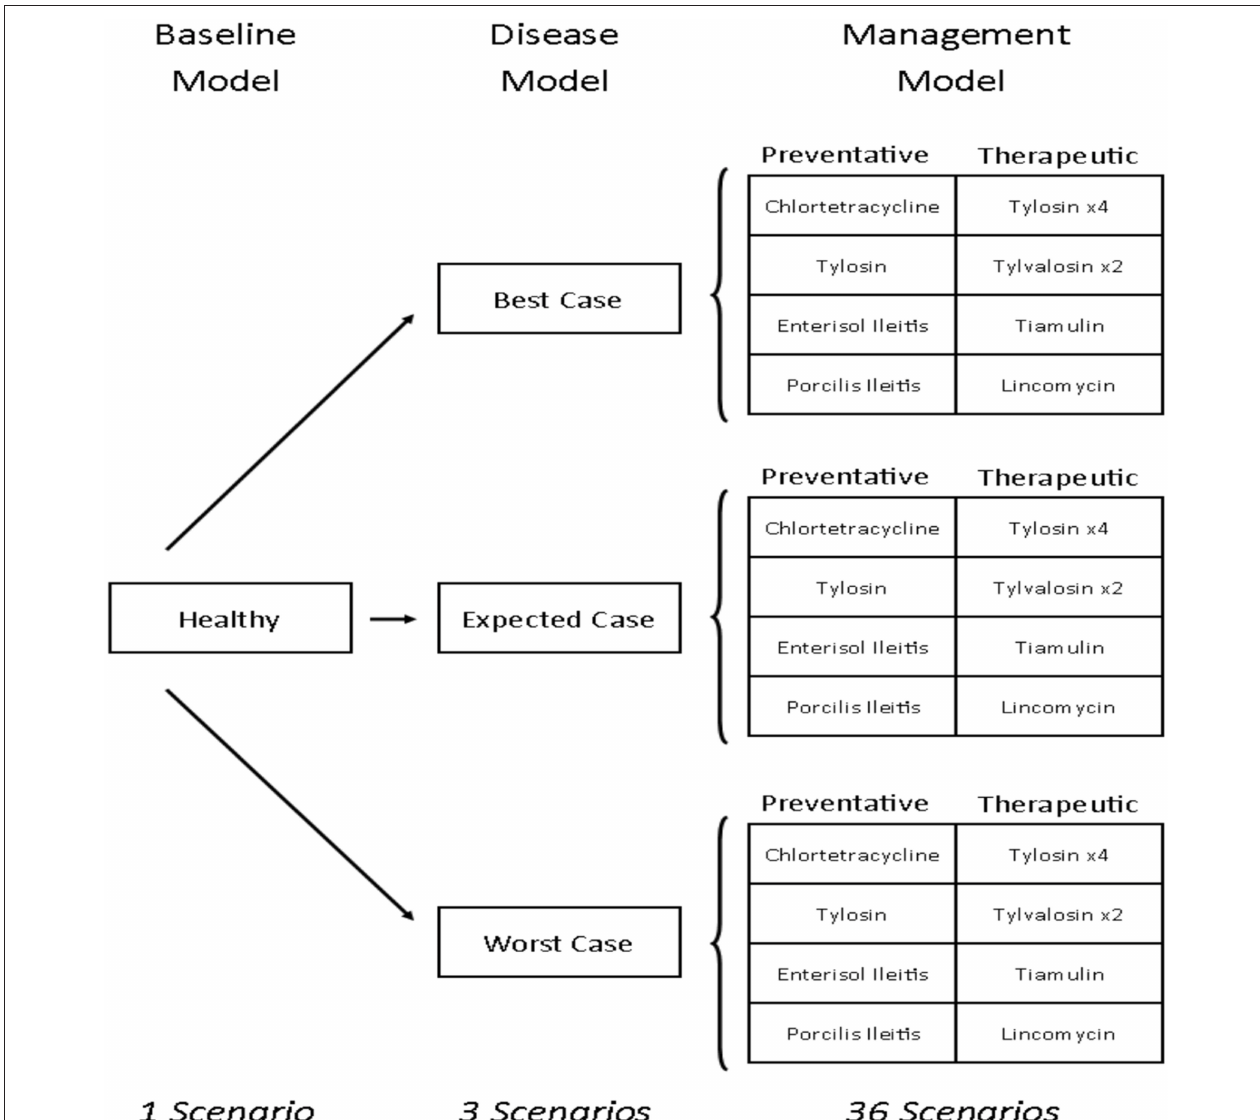
FIGURE 1 | Pig barn scenarios. Tylosin × 4 indicates that there are four different treatment options that use tylosin as the antibiotic. Tylvalosin × 2 indicates two different treatment options that use tylvalosin as the